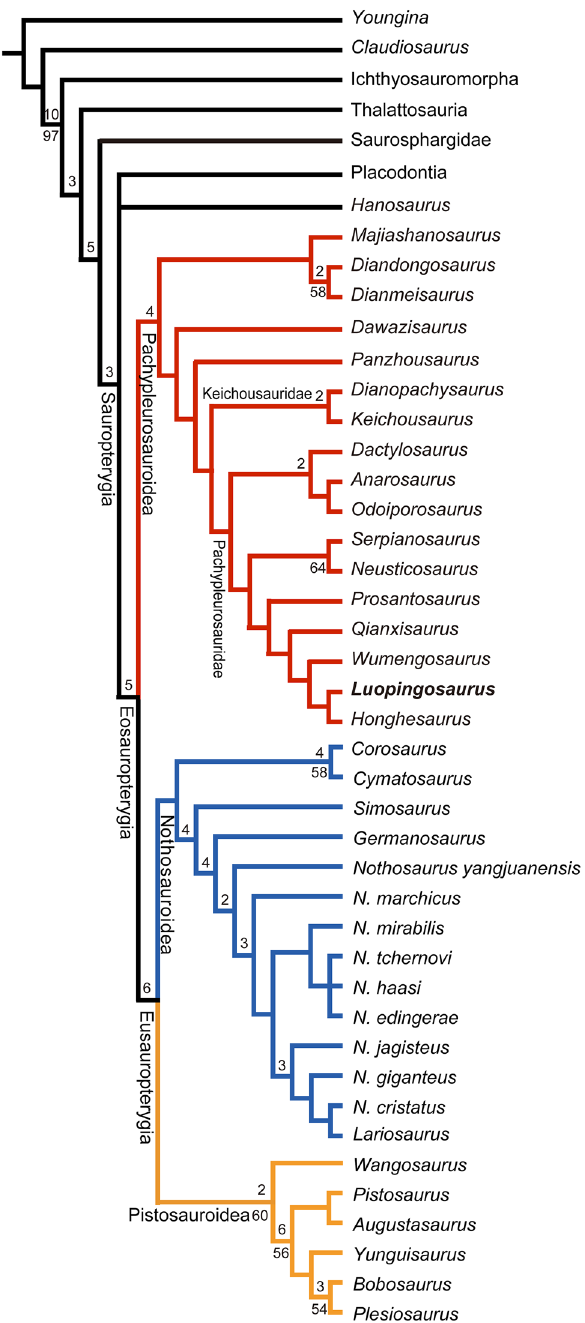
Figure 5. Phylogenetic position of Luopingosaurus imparilis gen. et sp. nov. Strict consensus of four trees rooted with Youngina (TL = 928, CI = 0.3211, and RI = 0.6836). Bremer decay indices larger than 1 and bootstrap values larger than 50% are indicated above and below the nodes of the tree,